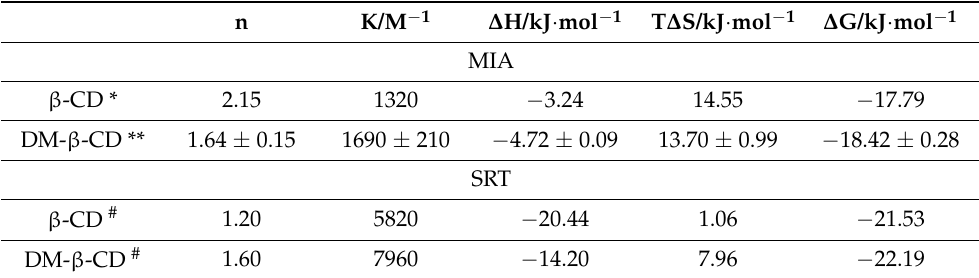
Table 1. Stoichiometry coefficients of binding (n), binding constants (K), enthalpy ( ∆ H), entropic effects (T ∆ S), and the Gibbs free energies values ( ∆ G) obtained for the complex formation of mianserin hydrochloride with β -cyclodextrin or heptakis (2,6-di-O-methyl)- β -cyclodextrin at T = 298.15 K under atmospheric pressure p = 101